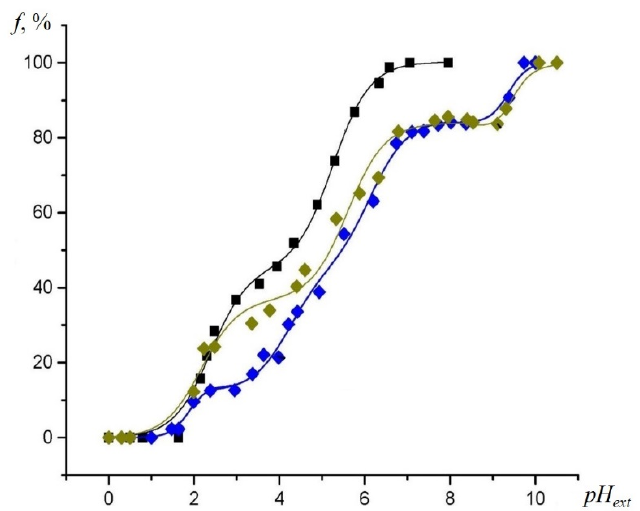
Figure 6. Experimental EPR titration curves for the NR at 293 K were obtained by plotting the fast- and slow-motioned component of the EPR spectra of the NR in the non-protonated form ( f ) vs. pH ext in aqueous solution ( black squares ), and inside the TiO 2 (7%)–SiO 2 ( blue diamonds ), TiO 2 (7%)– SiO 2 annealed at 850 °C ( green diamonds ), respectively.